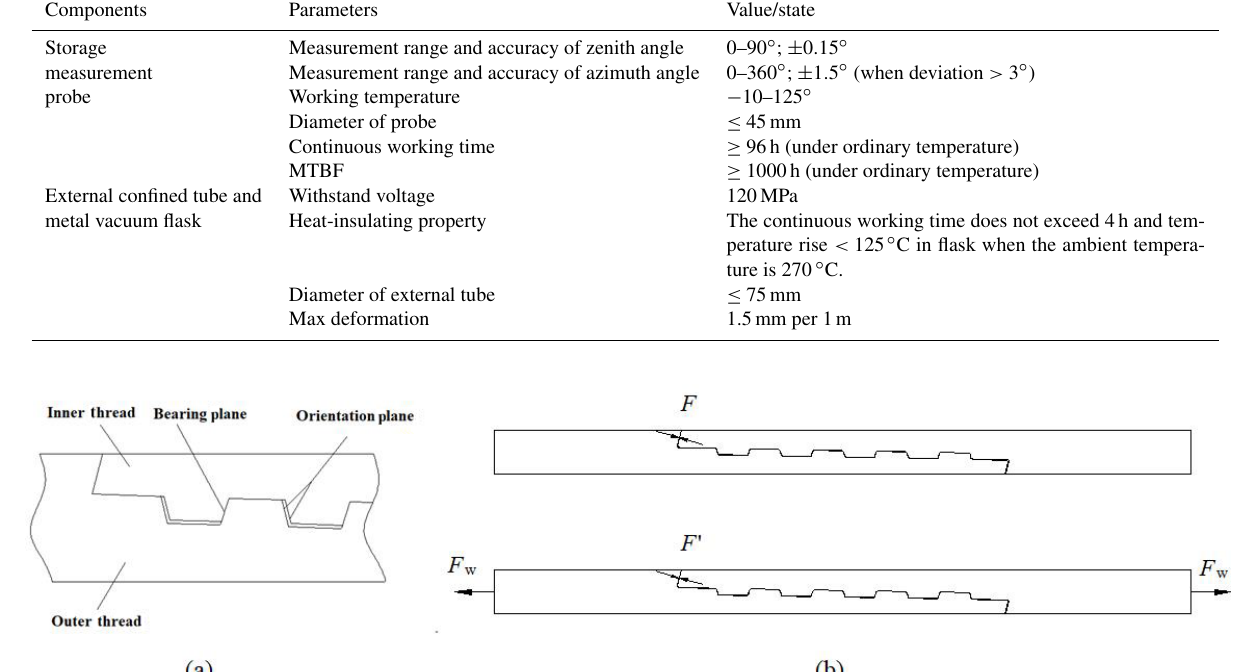
Table 2. Key technical parameters of the DTMI. MTBF is the mean time between failure.